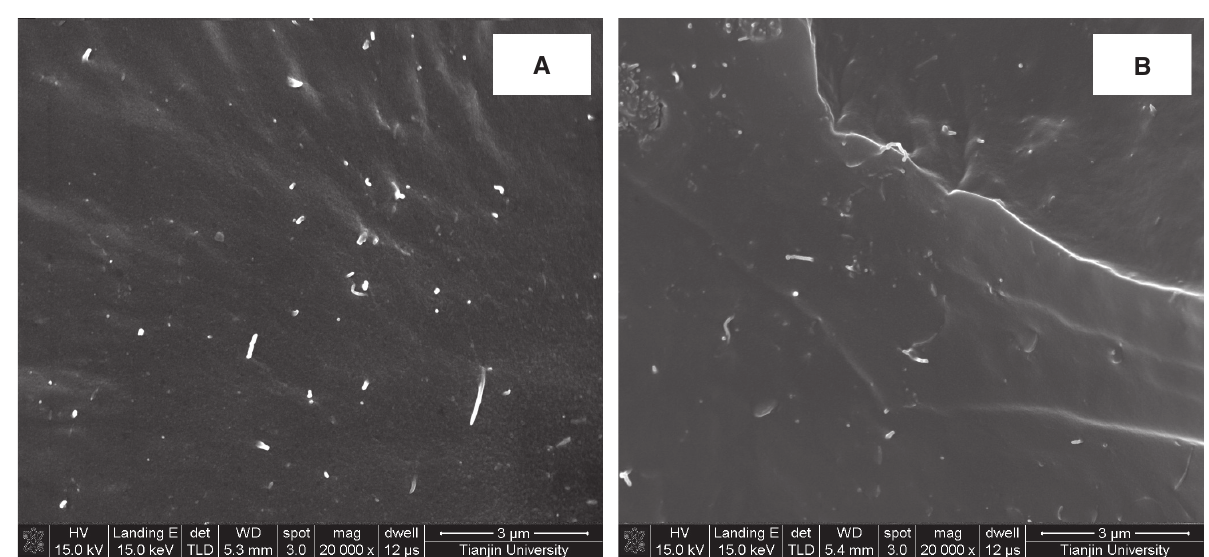
Figure 4 SEM images of tensile-fractured surfaces of the CNT-KH550/SE composites with 5 phr CNT-KH550: (A) S-CNT-KH550/SE, (B) L-CNT-KH550/SE.